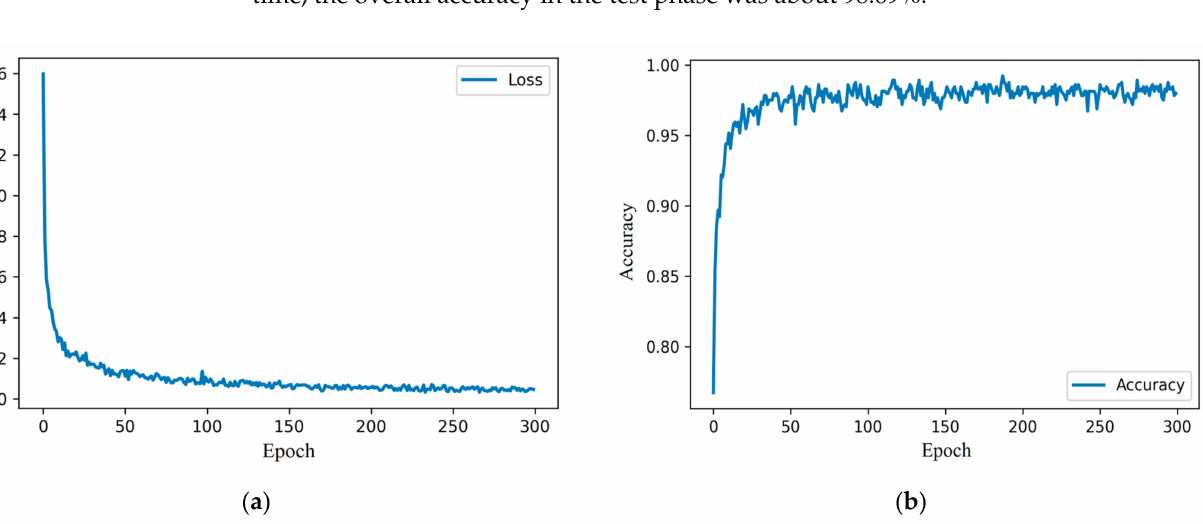
Figure 5. The model was trained with a training dataset and validating datasets: ( a ) Loss value; ( b ) Accuracy